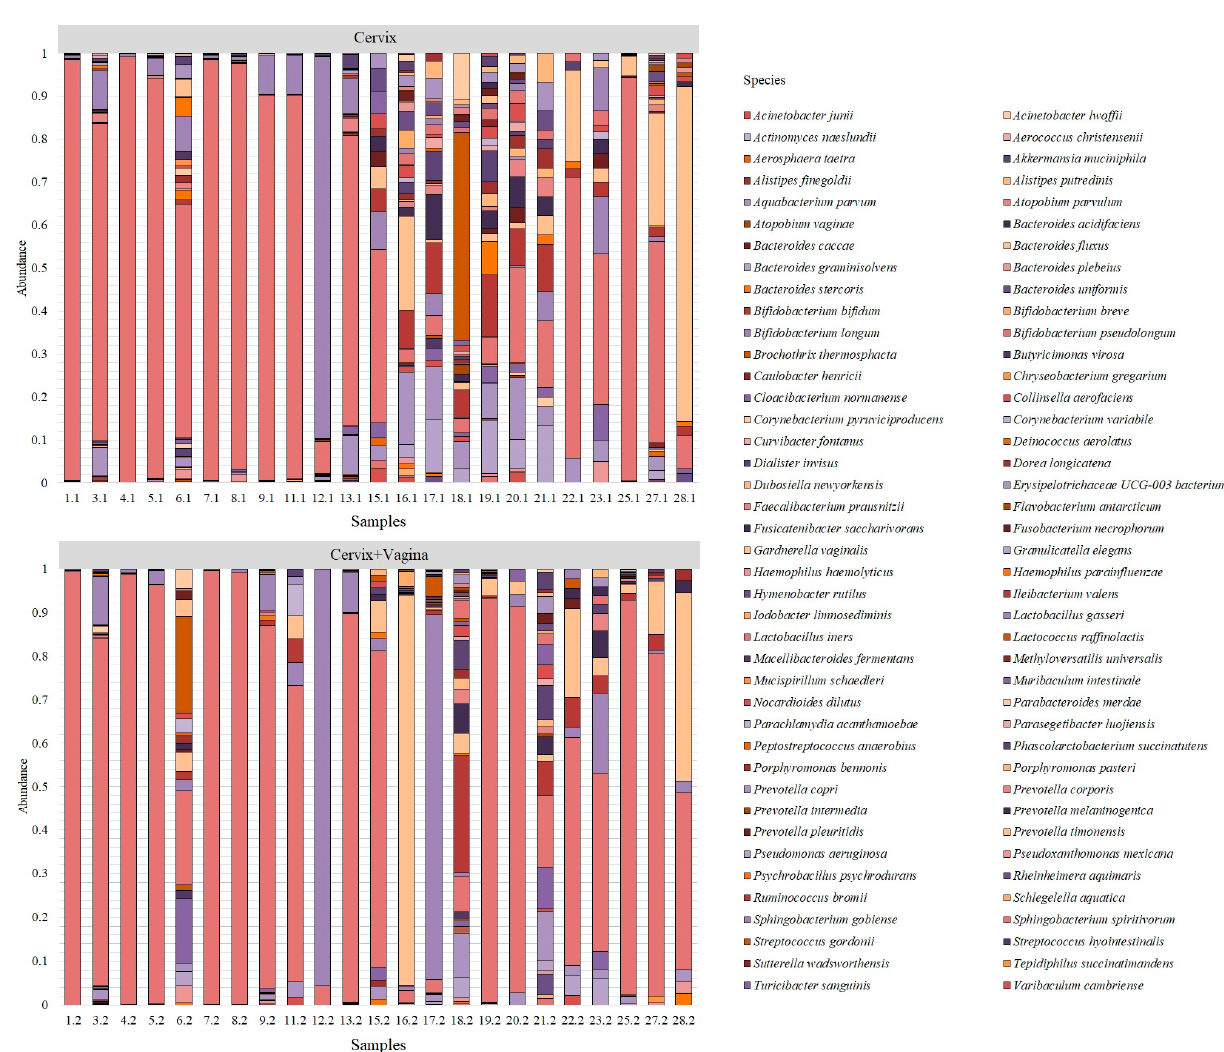
Figure 1. Bacterial species were detected in the studied samples using sequencing.